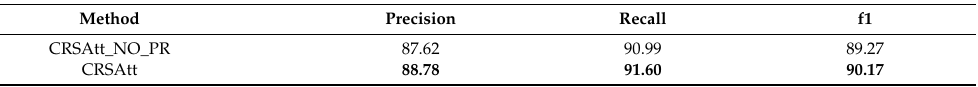
Table 11. Comparison of the model without prediction structure and the full model on the SemEval- 2010 Task 8